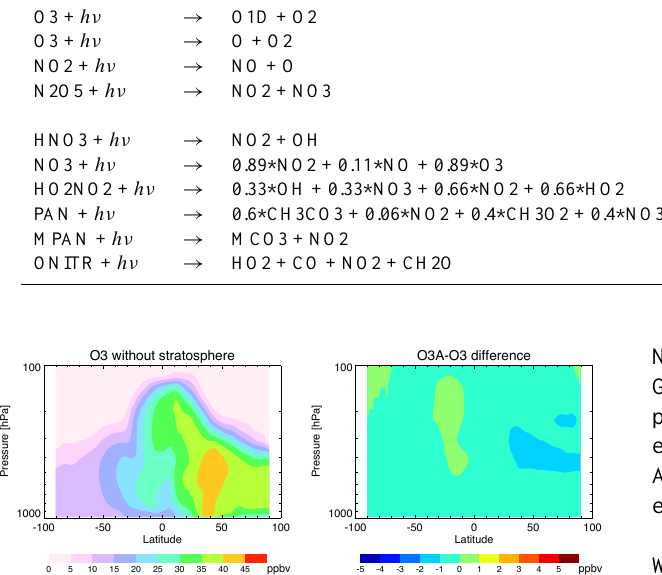
Table 2. Photolysis reactions of tagged species. Original reaction